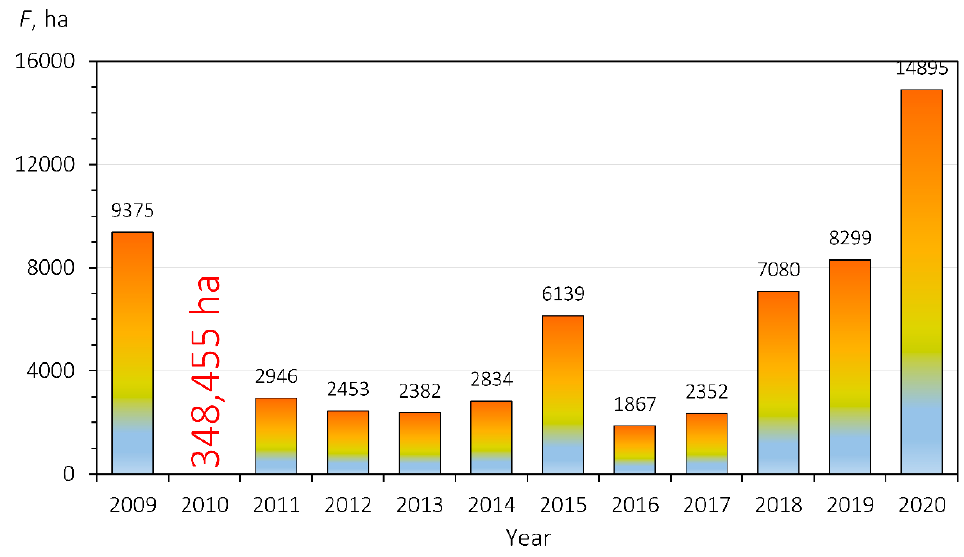
Figure 5. The total annual area of burned forest ( F ) in the Volga Federal District during 2009–2020. An analysis of the thunderstorm index was performed (Figure 6). Maps of the thunderstorm index averaged over 1979–2021 show that for the Volga Federal District, in May, the TT values in the predominant part of its territory were below 44 K, and only in the south of the region (Saratov Region and Penza Region, see Figure 1), they were TT = 44 K. In June and July, the TT throughout the entire Volga Federal District was 44–46 K, and minimum values were noted in the Cis-Ural Region. In August, on the whole, the field of TT values is similar, with values lower by 1–2 K (42–44 K, with a maximum in the central part of the Volga Federal District). Starting from September, the TT values over the VFD do not exceed 44 K, i.e., thunderstorms are unlikely.